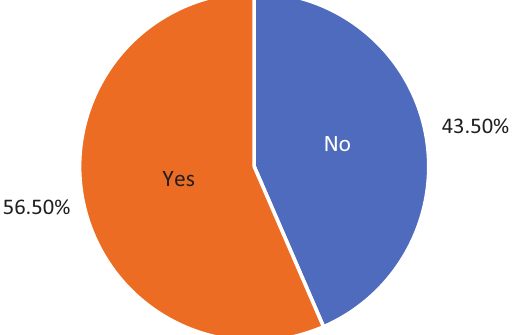
Figure 1. Answers to the question: Is your participation council an inclusive